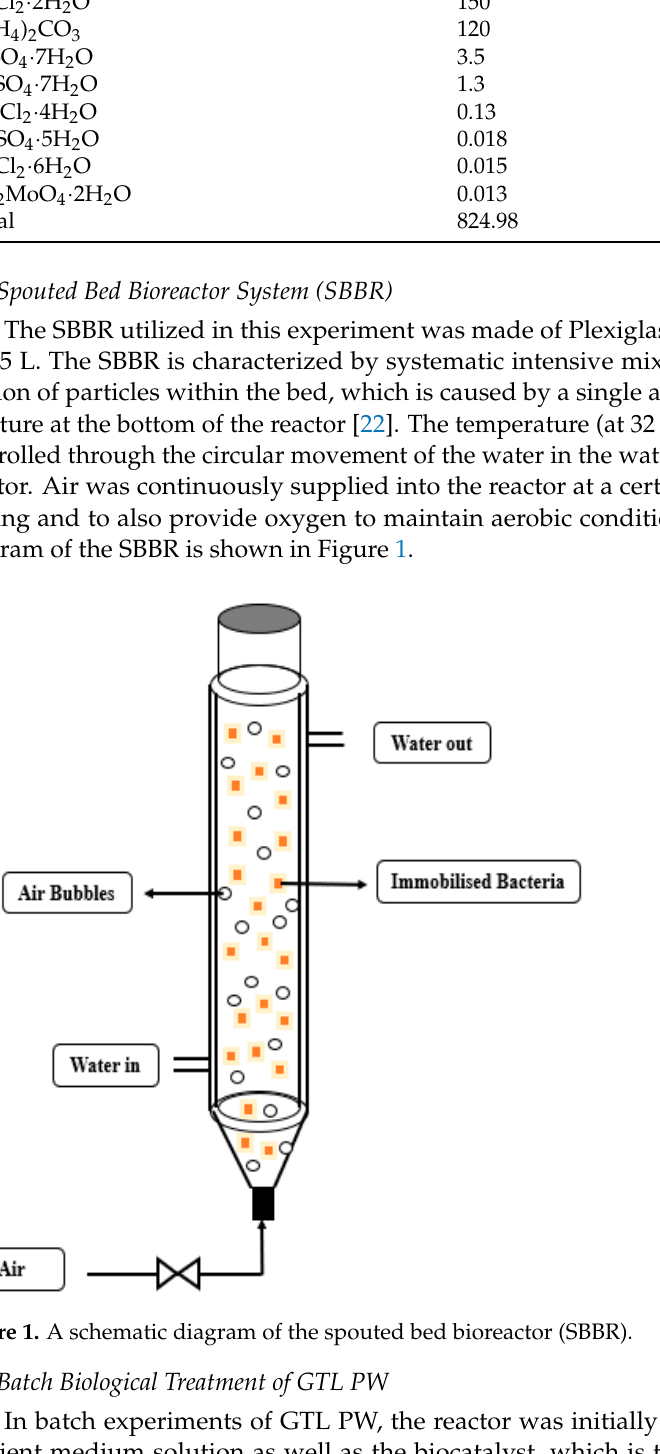
Table 2. Composition of the mineral salt medium [21].